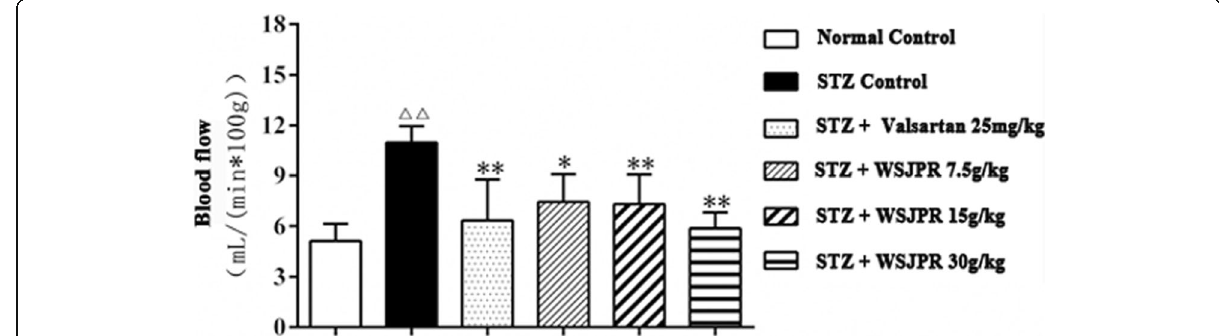
Fig. 4 Effect of WSJPR on the microcirculation blood flow in rats renal cortex ( n = 8). △△ P < 0.01 vs. normal control and * P < 0.05, ** P < 0.01 vs. STZ control; mean ± SD